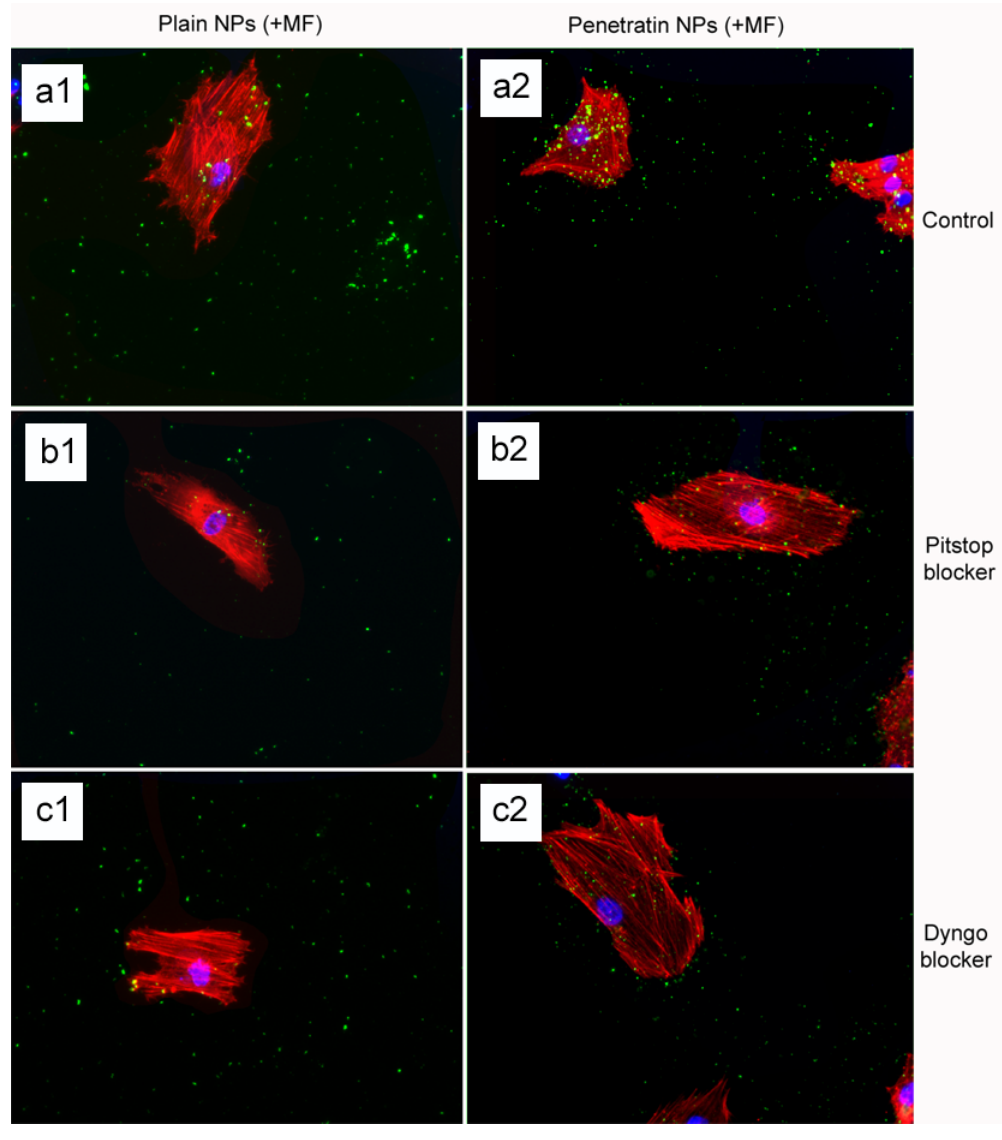
Figure 8. Fluoresence microscopy of plain and penetratin 200 nm particle uptake into cells in the presence of a magnetic field, incubated with either Pitstop or Dyngo endocytosis